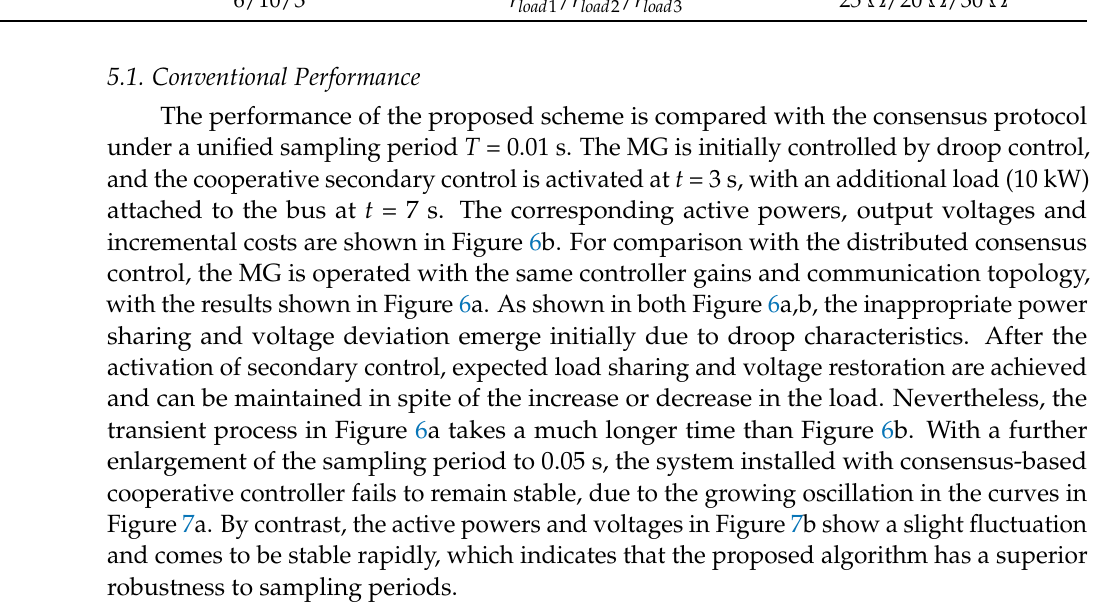
( a ) ( b ) Figure 7. Simulation results of active powers and output voltages with sampling interval as 0.05 s using different algorithms. ( a ) Consensus algorithm. ( b ) Fast convergence algorithm. 5.2. Arbitrary Sampling The asynchronous consensus concern that is inherent in distributed control is inves- tigated in this case. Due to the absence of a centralized clock, uncertainties inevitably oc- cur and are assumed to be within ±10% T i on the basis of the individual sampling periods T 1 = 0.05 s, T 2 = 0.01 s, T 3 = 0.02 s, T 4 = 0.06 s, T 5 = 0.07 s, with associated arbitrary sampling intervals shown in Figure 8 [28]. Simulation results in this case are displayed in Figure 9,